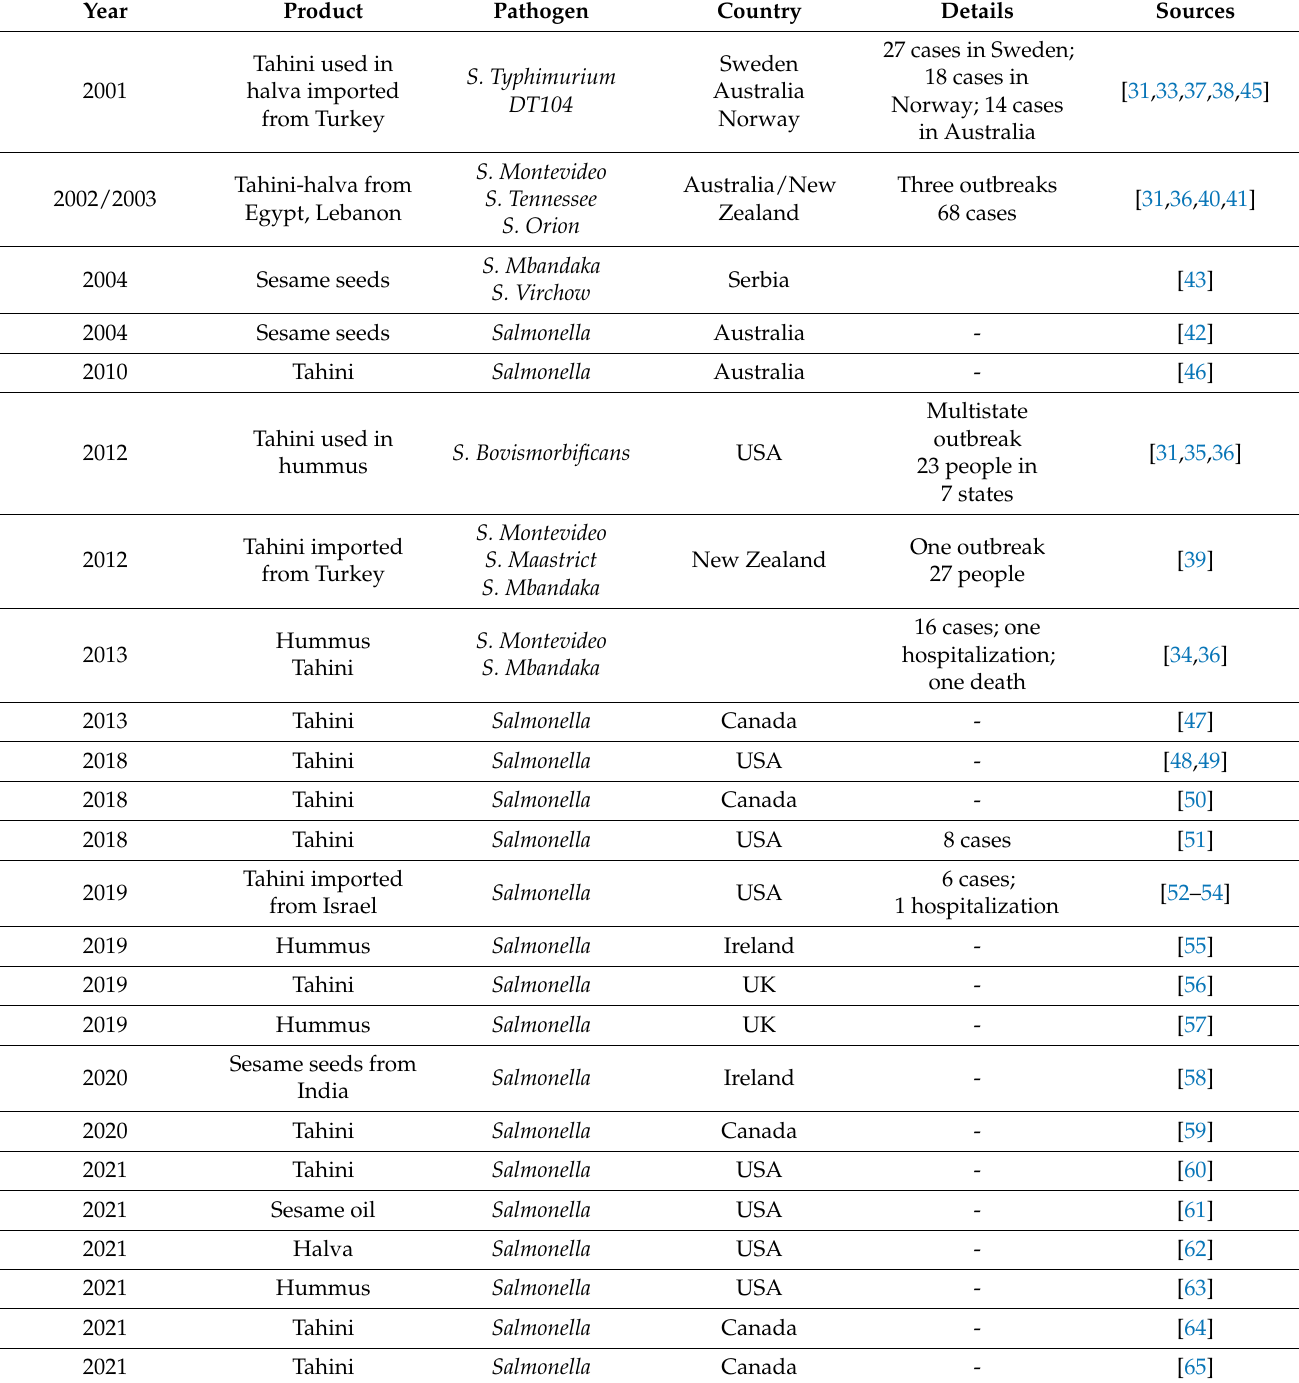
Table 1. Food withdrawals, recalls, and foodborne illness incidents associated with Salmonella and sesame seeds